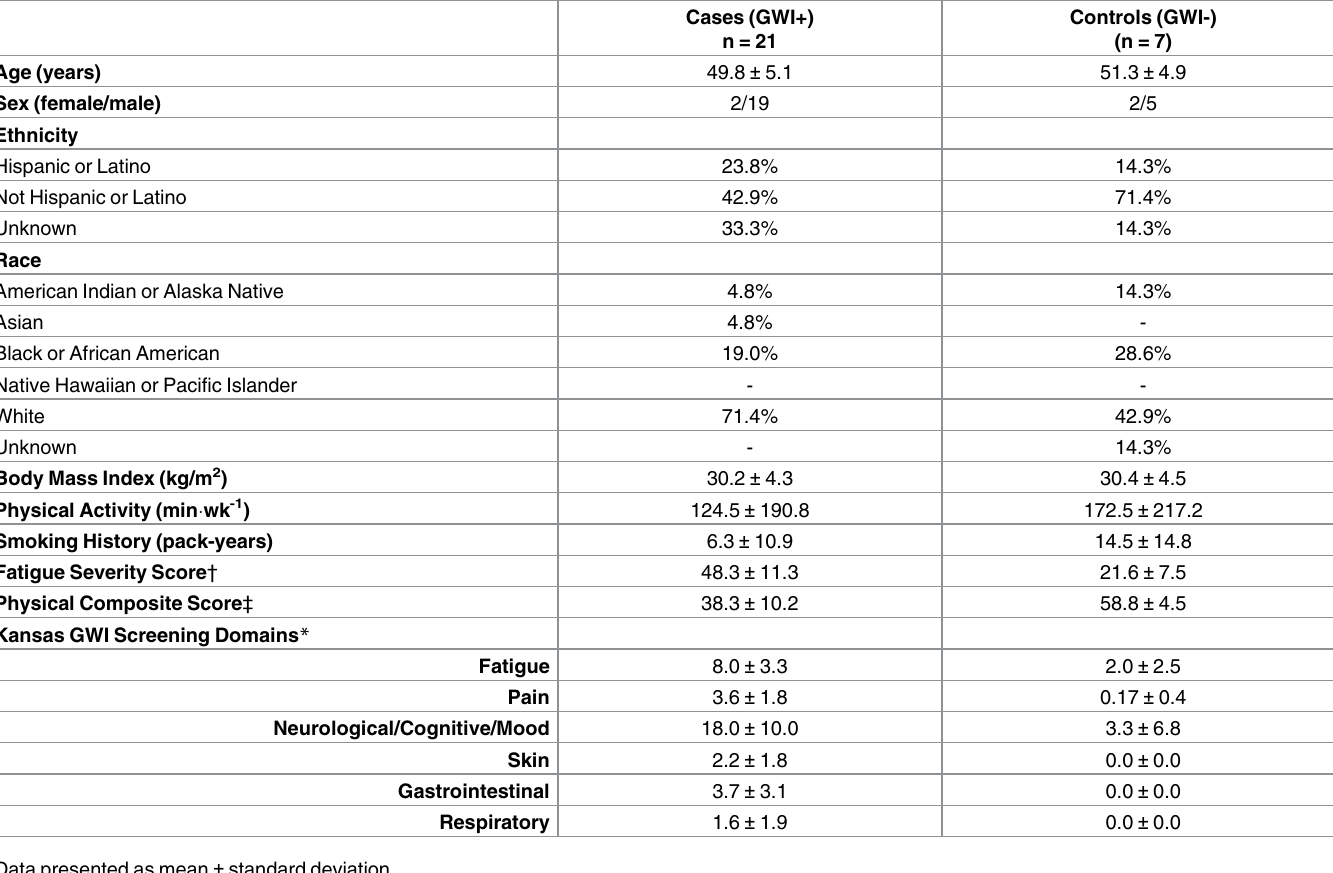
Table 1. Participant characteristics and self-reported symptoms for caseswith (GWI+) and without (GWI-) Gulf War